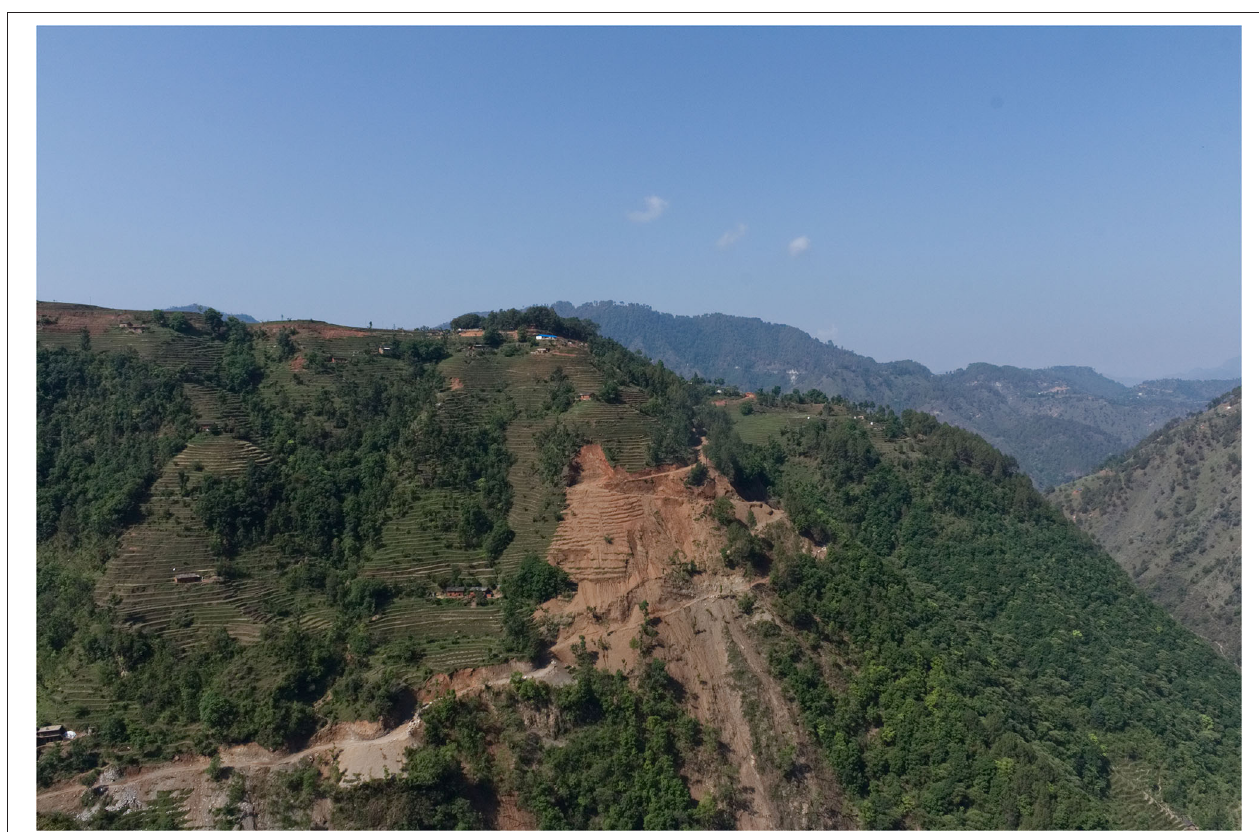
FIGURE 10 | Landslides caused by poorly-implemented road construction in